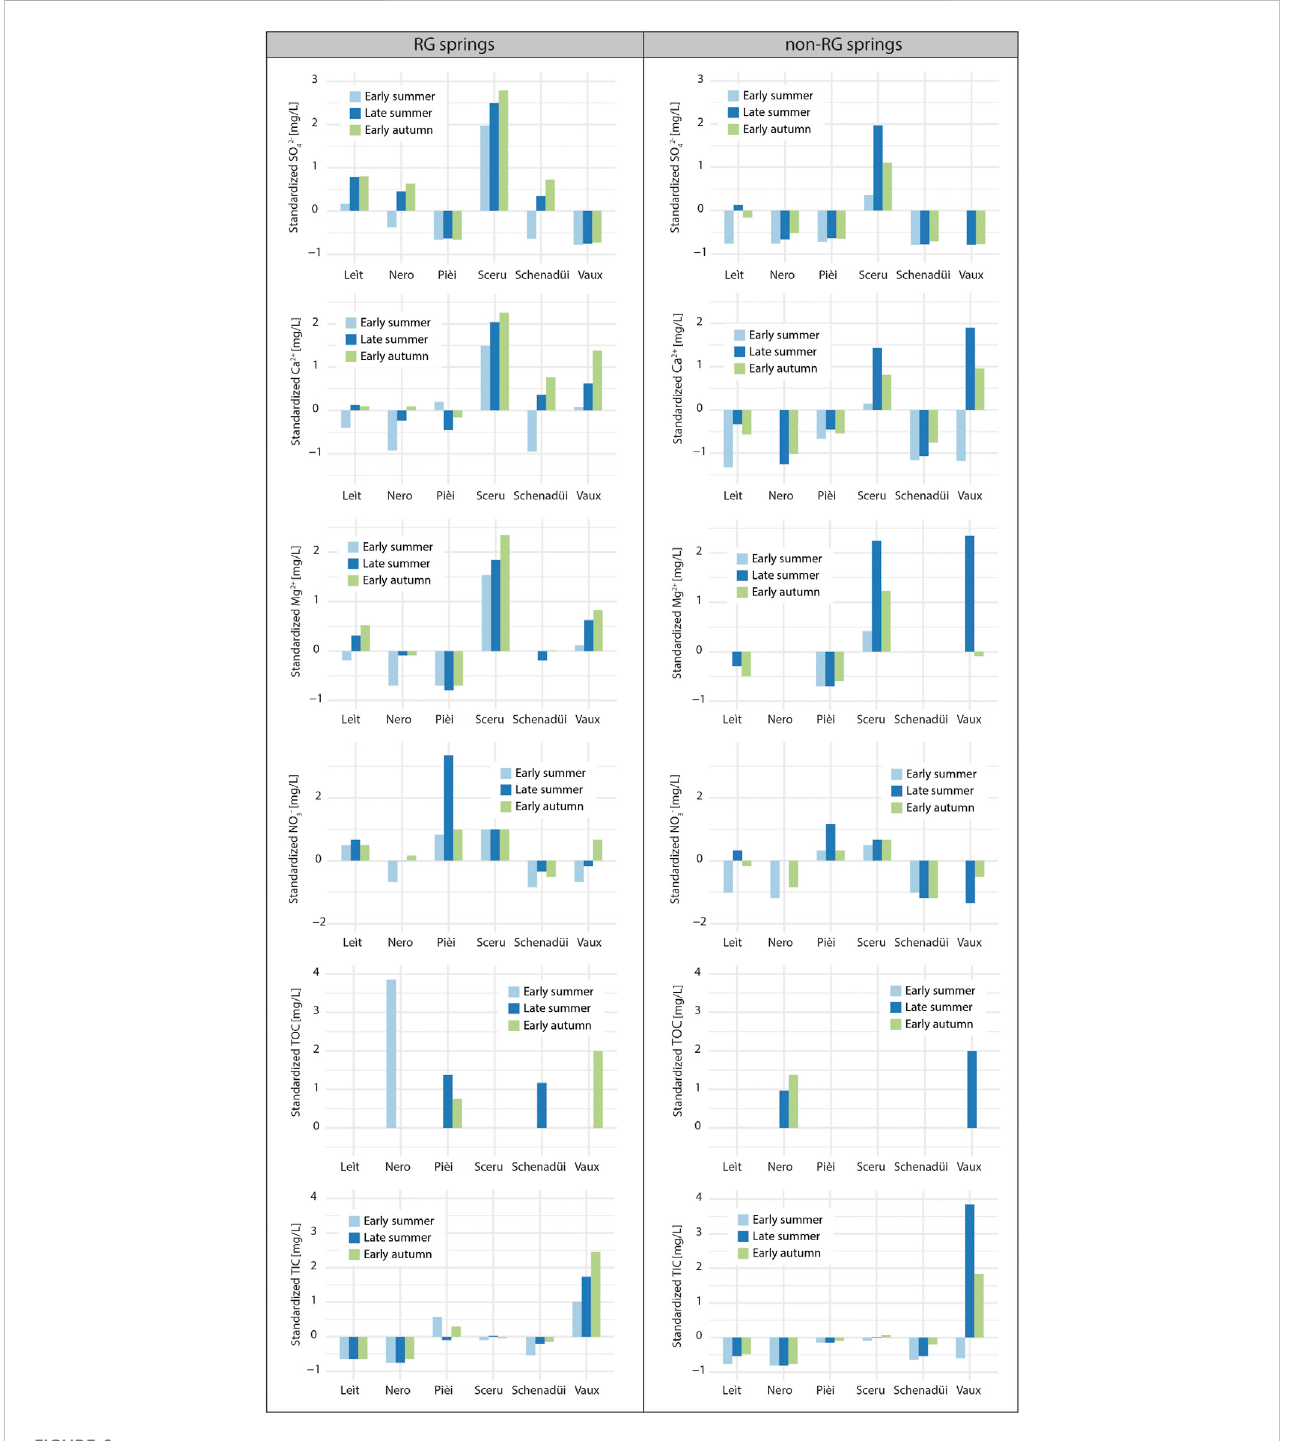
FIGURE 6 Chemical parametersmeasured in RG springs (left column) and non-RG springs (right column) during thewarm season. Values were standardized using Z-scores.